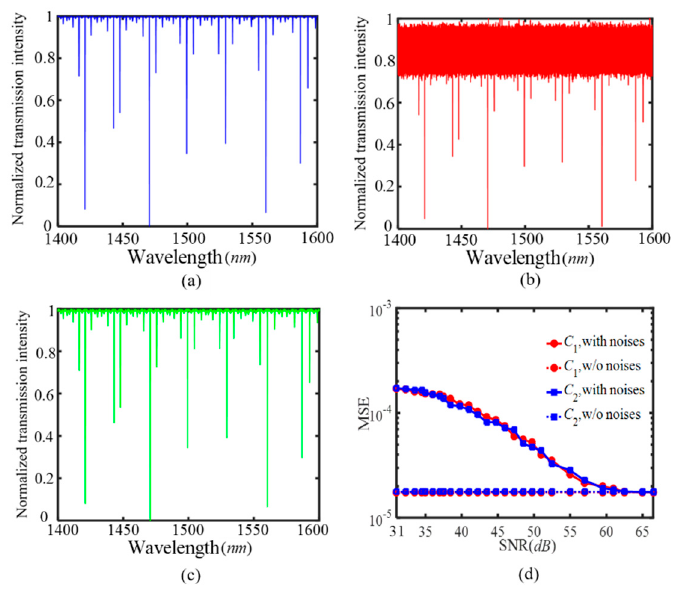
Figure 6. For the designed two-parameter SIMRR sensor in Figure 3a, the simulated transmission spectra in the wavelength range of 1400–1600 nm at gas concentration C 1 = C 2 = 0.01 ( a ) without noises, ( b ) with SNR = 15 dB ( c ) with SNR = 30 dB. ( d ) The root-mean-square error of measurement results by the BP-ANN versus the SNR value.